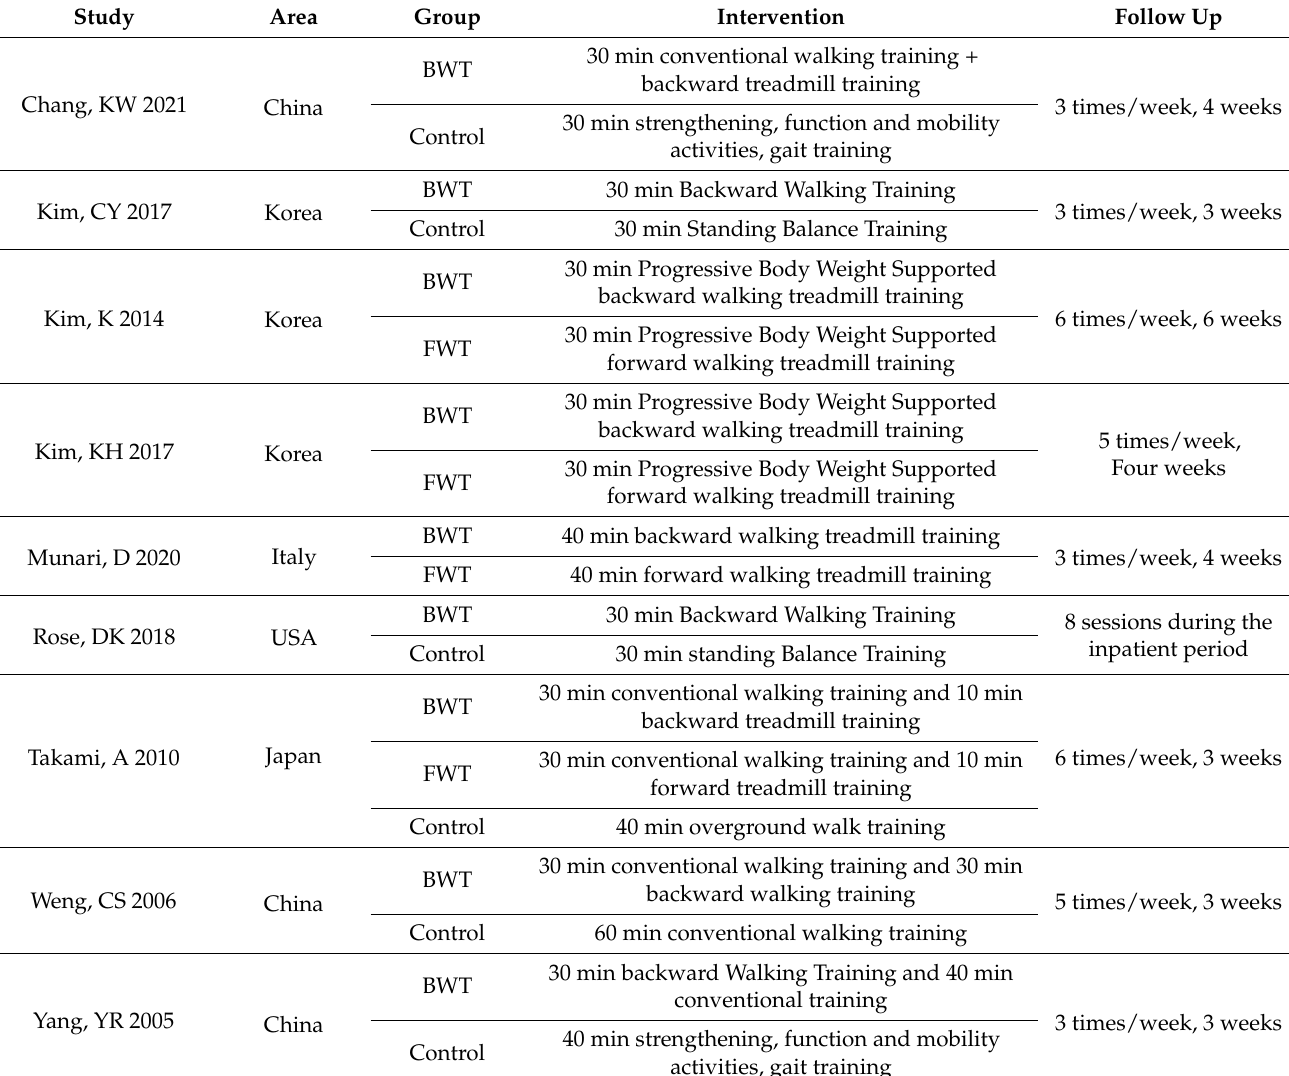
Table 1. Interventions included in the